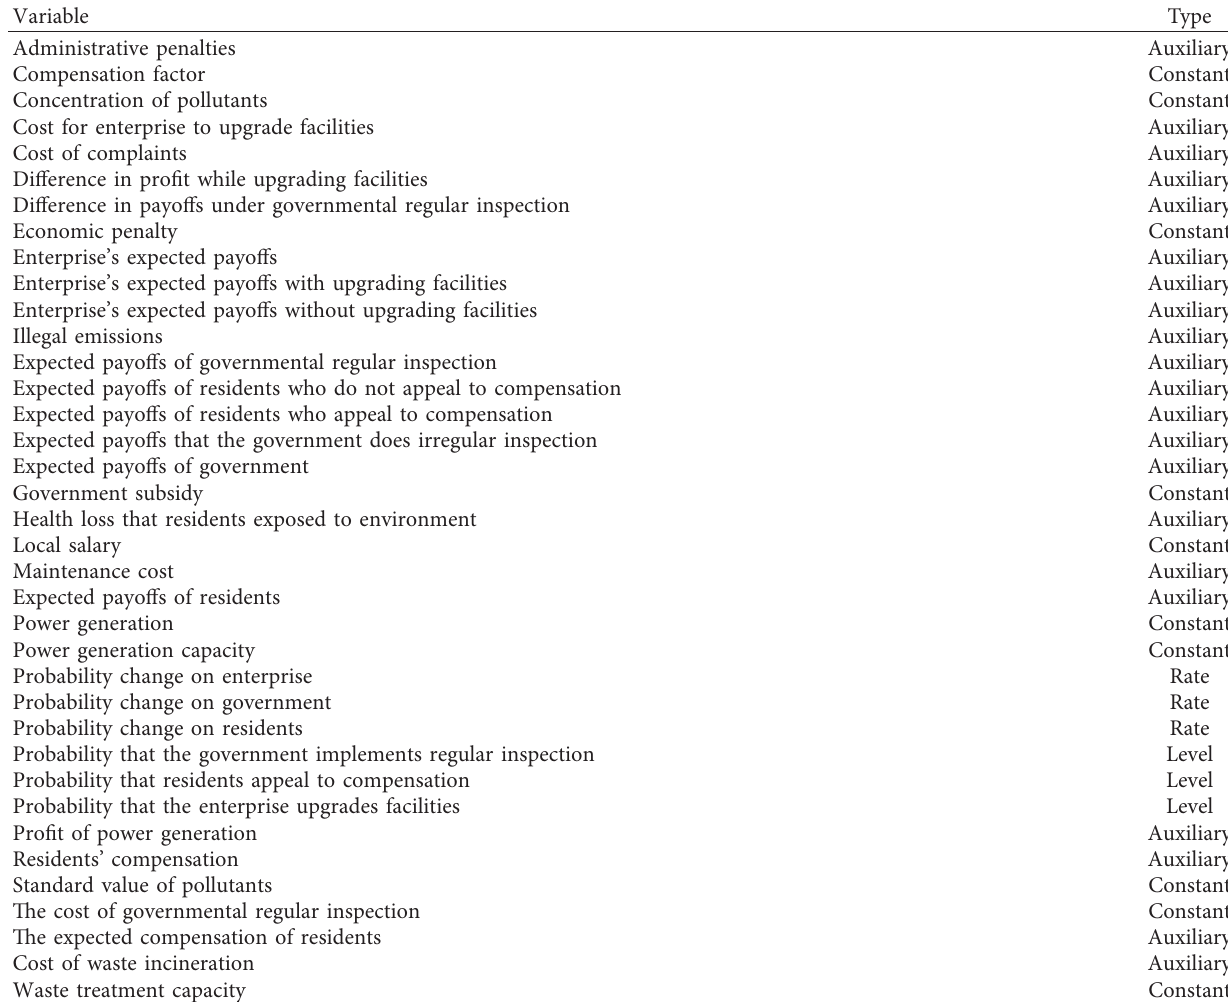
Table 4: Variable type of the SD